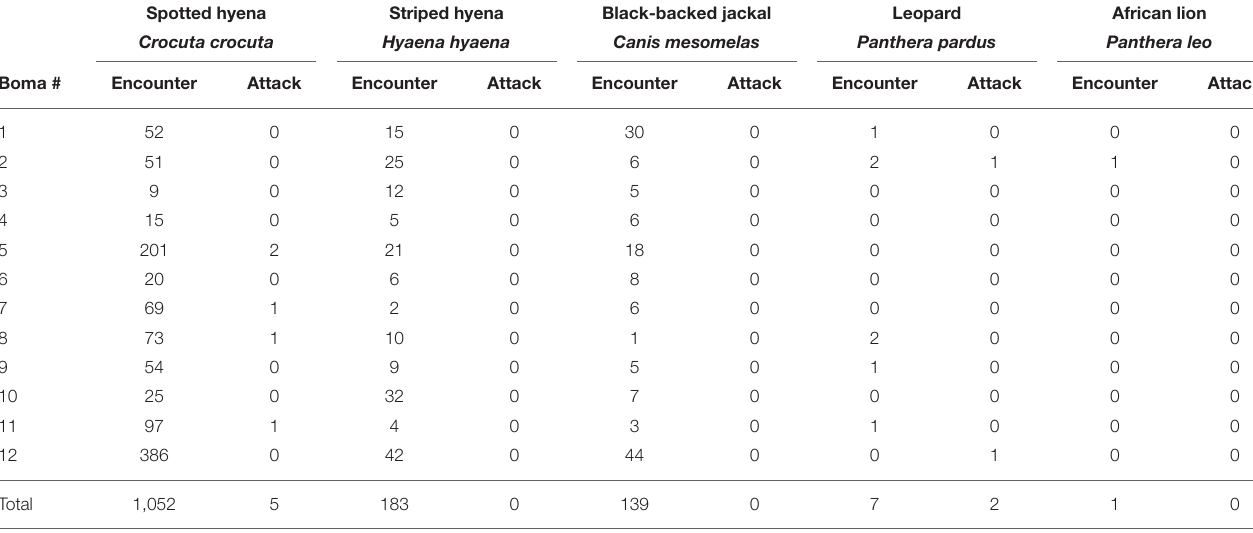
The results are shown by boma for the five depredating carnivore species recorded.